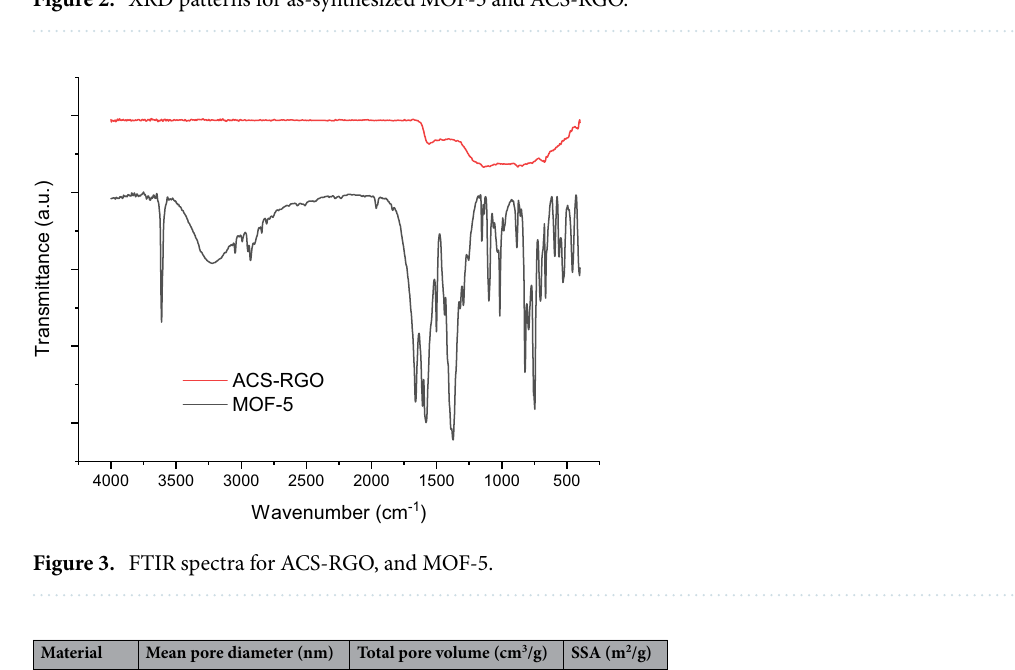
Figure 2. XRD patterns for as-synthesized MOF-5 and ACS-RGO.